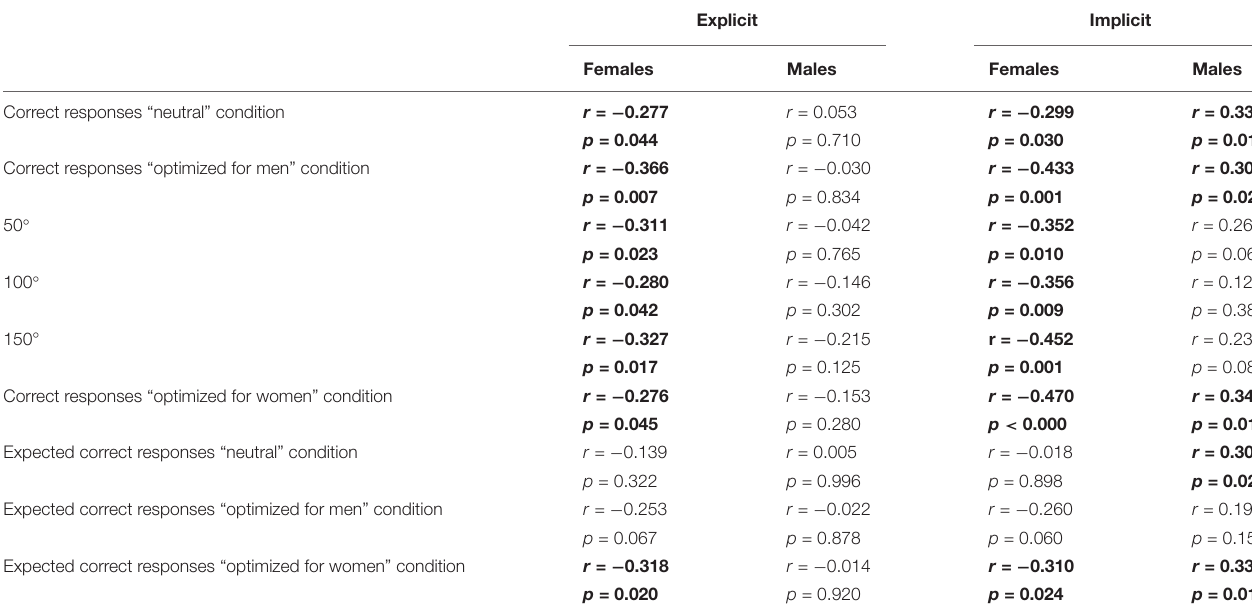
TABLE 2 | Correlations by